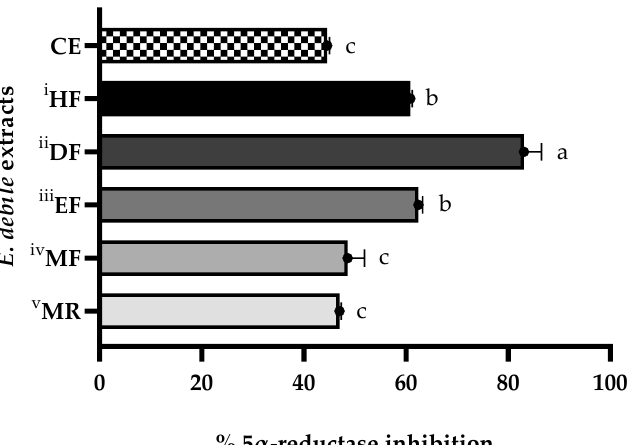
Figure 9. Anti-5 α -reductase activities of E. debile extracts. i–v Successive partition of crude extract (CE) (10.45 ± 1.20 g) into hexane fraction (HF), dichloromethane fraction (DF), ethyl acetate fraction (EF), methanol fraction (MF), and methanol insoluble residue (MR). All data are presented as mean ± SD of triplicates. Letters (a, b, and c) indicate significant differences of means between the groups based on Tukey’s HSD one -way ANOVA ( p -value < 0.05).